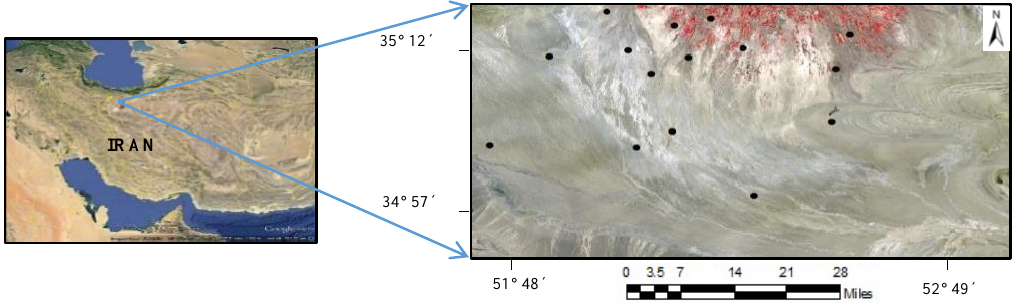
Figure 1. Study area using Landsat ETM + data and some field surveying points.